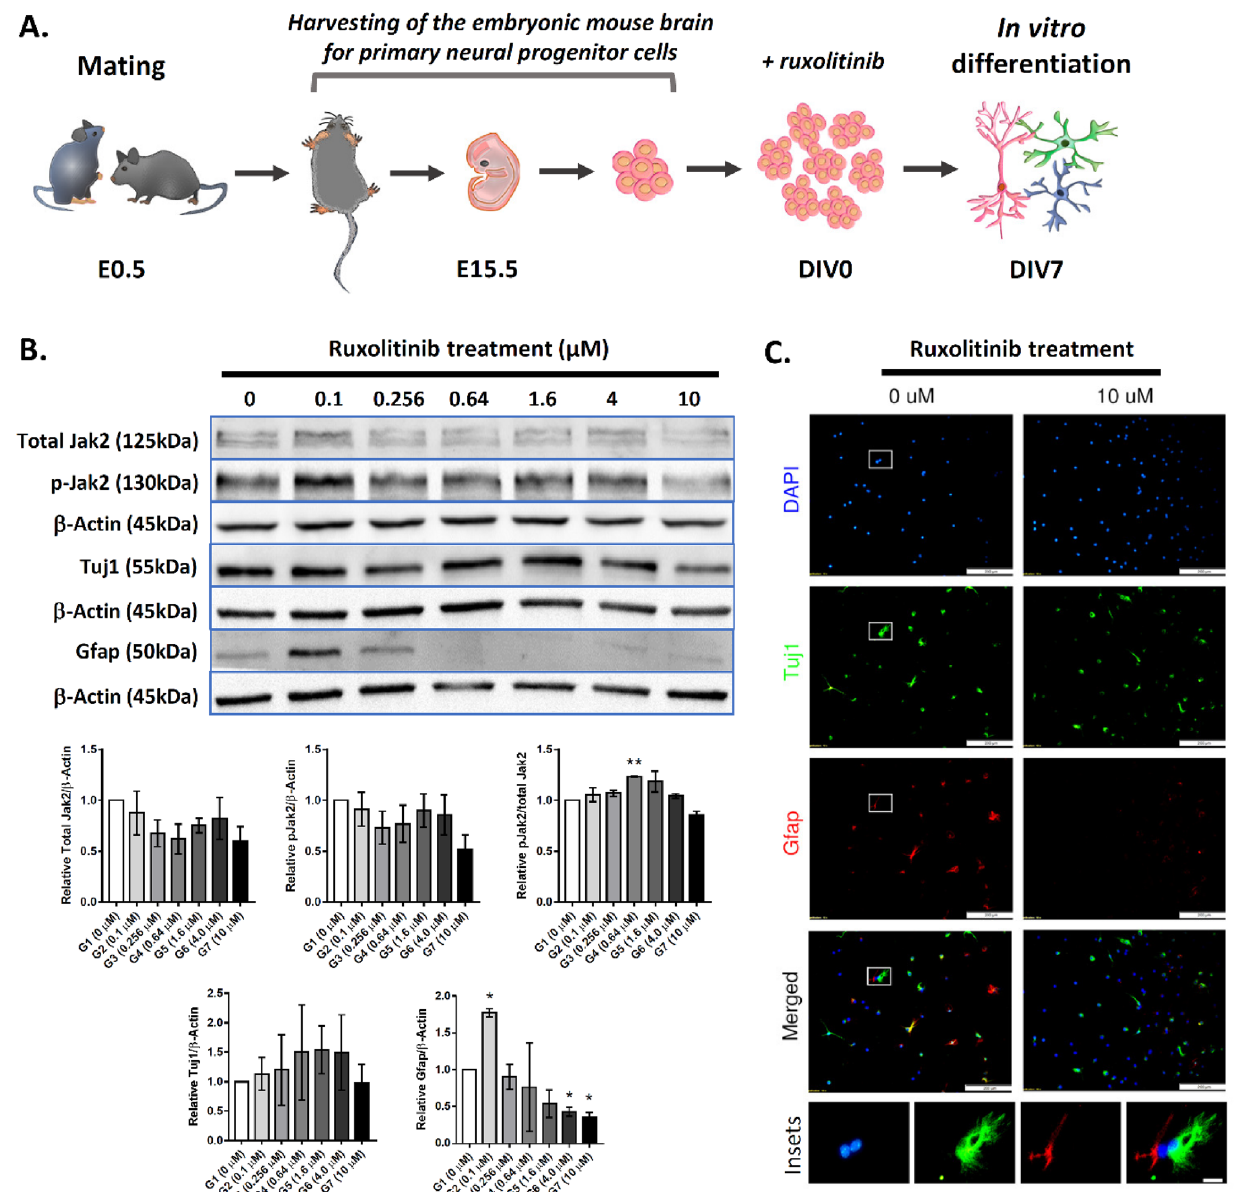
Figure 3. Assessment of the gliogenic-suppression effect of ruxolitinib in differentiating neurospheres ex vivo. ( A ) A schematic diagram depicting the study outline of ex vivo differentiation of neurospheres for ruxolitinib treatment. ( B ) Immunoblotting analysis for total Jak2, phosphorylated Jak2 (n = 2 per group), Tuj1 and Gfap (n = 2 per group) in vehicle control (G1) and all treated groups (G2-G7). The corresponding pixelation analysis of immunoblotting bands is shown below to the blots (n = 2 per group; Welsh’s t-test). ( C ) Immunocytochemistry staining of Tuj1 and Gfap in differentiating neurospheres in control and 10 μM ruxolitinib treated groups (n = 2 per group). The higher magnification of insets in the control group is shown at the bottom of the micrographs. The colour of the insets corresponds to the DAPI (blue), Tuj1 (green) or Gfap (red). Scale bars represent 200 μm in all micrographs whereas 20 μm in the insets. All values represent mean ± SEM; * denotes adjusted p < 0.05; ** denotes adjusted p < 0.01. See Fig. S4 for original immunoblots (Supplementary